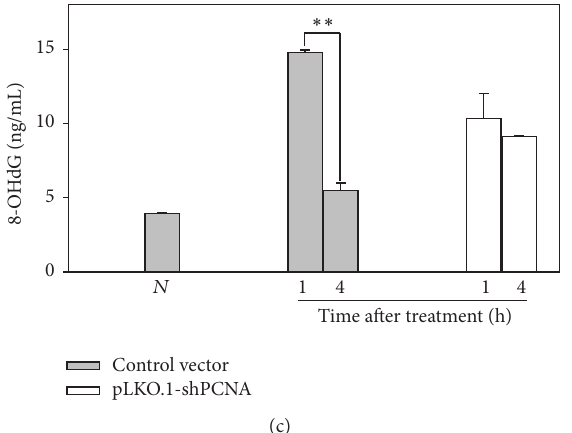
Figure 6: The effect of PCNA knockdown on the repair of oxidative DNA damage. (a) Comet assay. AGS cells transfected with pLKO-1 shPCNA to knock down PCNA or control vector were treated with 20 𝜇 M H 2 O 2 for indicated periods of time before being harvested for comet-Fpg/Endo III assay to monitor the levels of H 2 O 2 -induced DNA lesions in cells. Bottom panel: western analysis of PCNA protein with levels of 𝛽 -actin protein as a loading control. (b) Immunostaining analysis and (c) ELISA. Cells transfected with pLKO-1 shPCNA or control vector were treated with 1mM H 2 O 2 for 1 and 4h before being harvested for immunofluorescence and ELISA assays of 8-oxo-dG. Typical images were shown. 𝑁 for control, that is, cells without treatment. ∗∗ for 𝑝 < 0.005